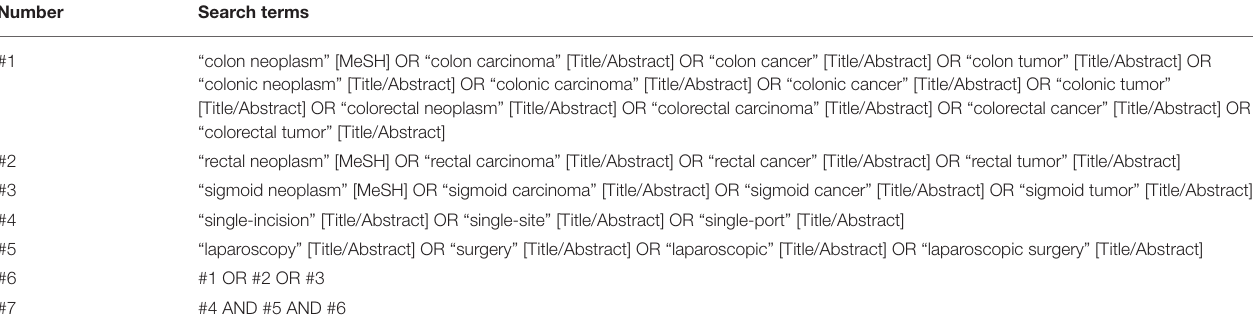
TABLE 1 | PubMed search strategy of single-incision vs. conventional laparoscopic surgery for colorectal cancer